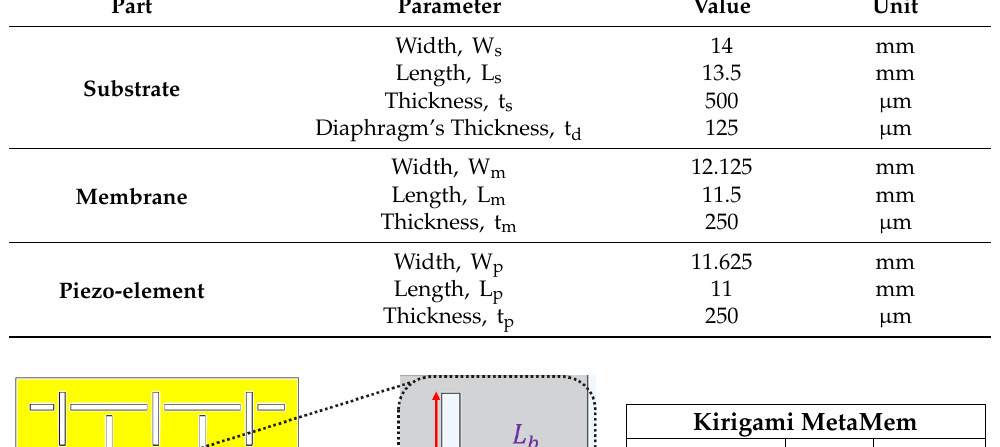
Table 1. Parameter values used in the pressure sensor models.